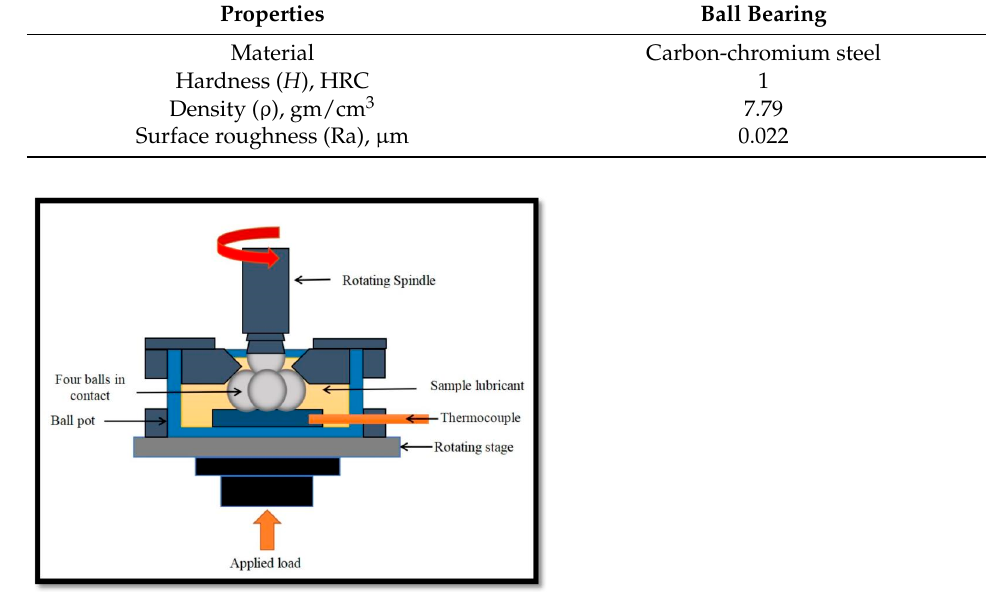
Figure 1. A schematic drawing of the experimental configuration of the four-ball tribotesters.